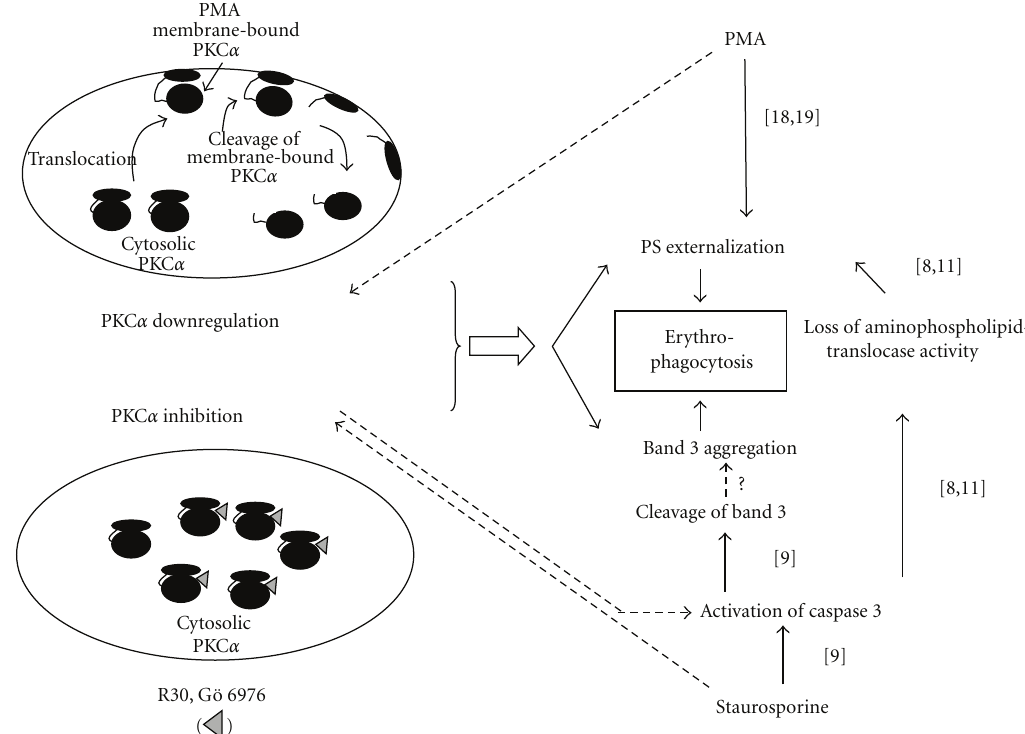
Figure 3: PKC α in eryptosis. Literature reports the role of activation of PKC/PKC α in the expression of externalized PS. We demonstrate that loss of PKC α activity due to inhibition or activation-linked down fregulation causes expression of not only externalized PS but also aggregated band 3. These observations along with other reports (given in brackets along the arrows) are linked to further understand the molecular mechanism of eryptosis. The molecular pathway of eryptosis emerging from the reports and the present study suggests exploration of the role of PKC α inhibition in activation of caspase 3 (indicated by dotted lines) which causes expression of both the markers of senescence.